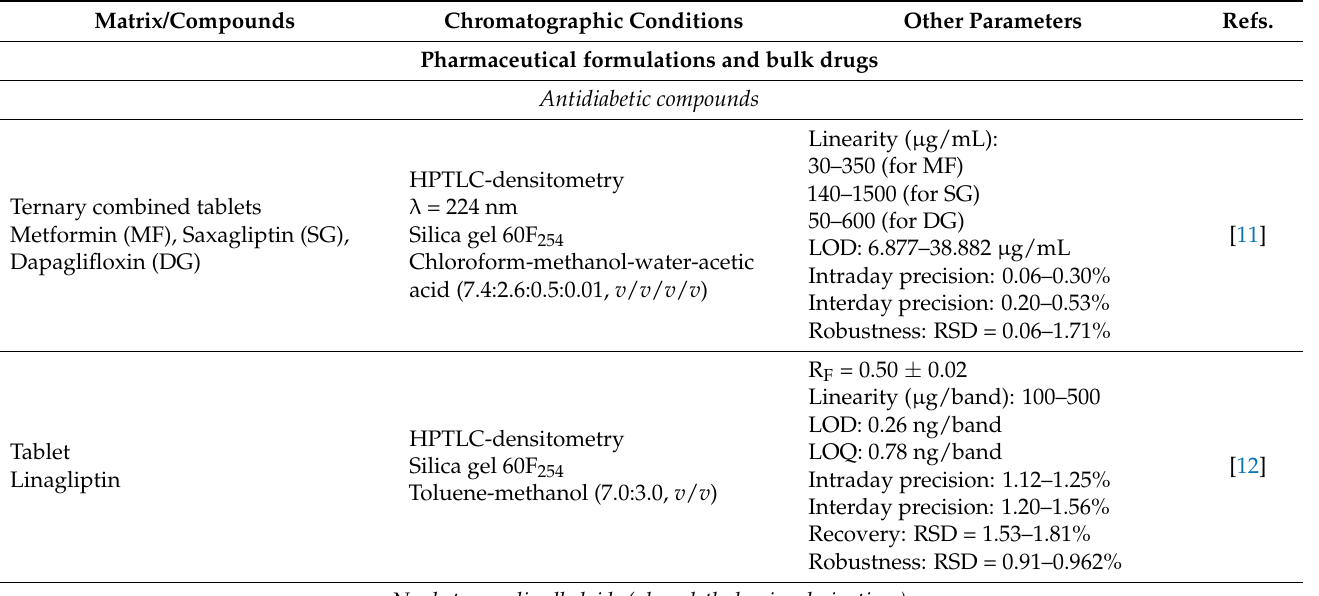
Table 1. Drug and pharmaceutical raw materials analyzed by